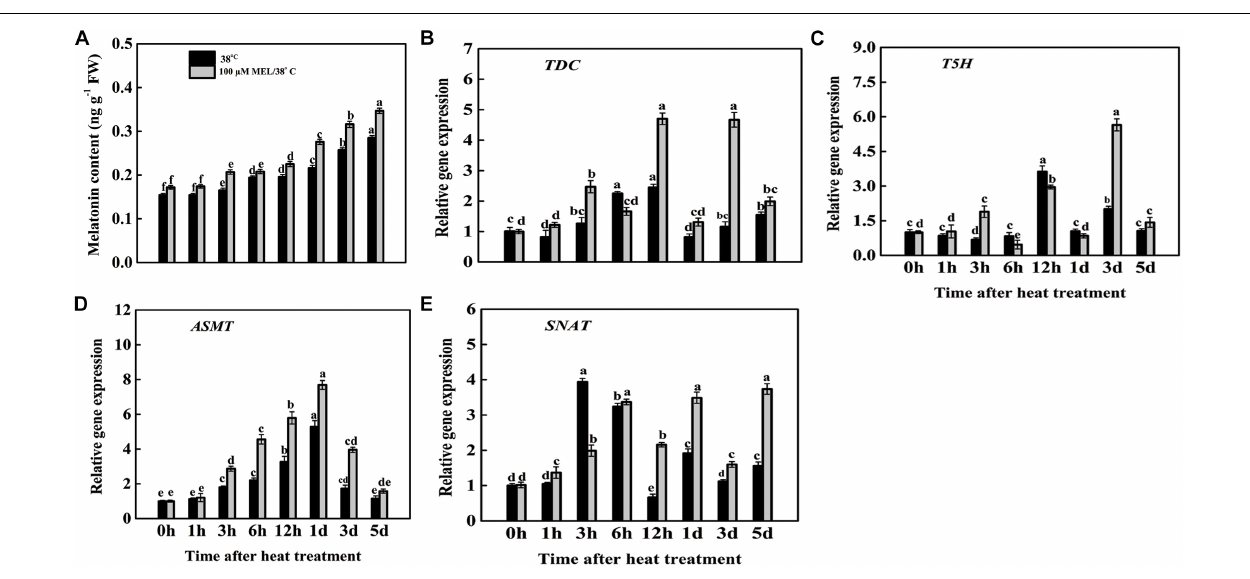
FIGURE 4 | Effects of exogenous melatonin treatment on the (A) endogenous melatonin content and (B–E) transcript abundance of melatonin biosynthesis genes ( TDC, T5S, ASMT, and SNAT ) during heat stress with or without of melatonin treatment. Different letters denote the significant variations between the treatments and the average values were measured by Tukey’s Honestly Significant Difference (HSD) test at P < 0.05. Data represented as the mean ± standard error of triplicate biological